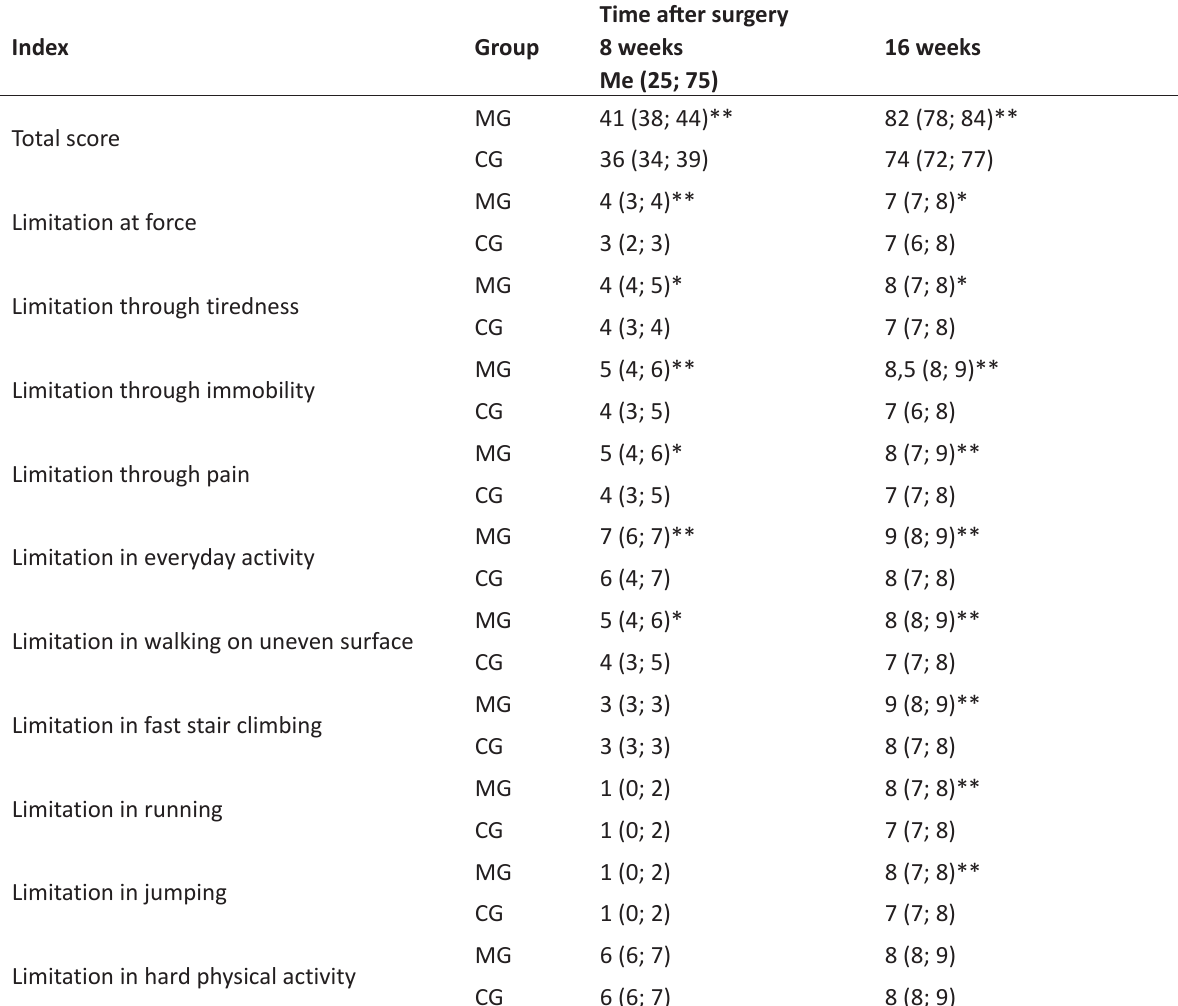
Table 2. Statistical indicators of quality of life (Achilles tendon total Rupture Score) in the dynamics of rehabilitation,